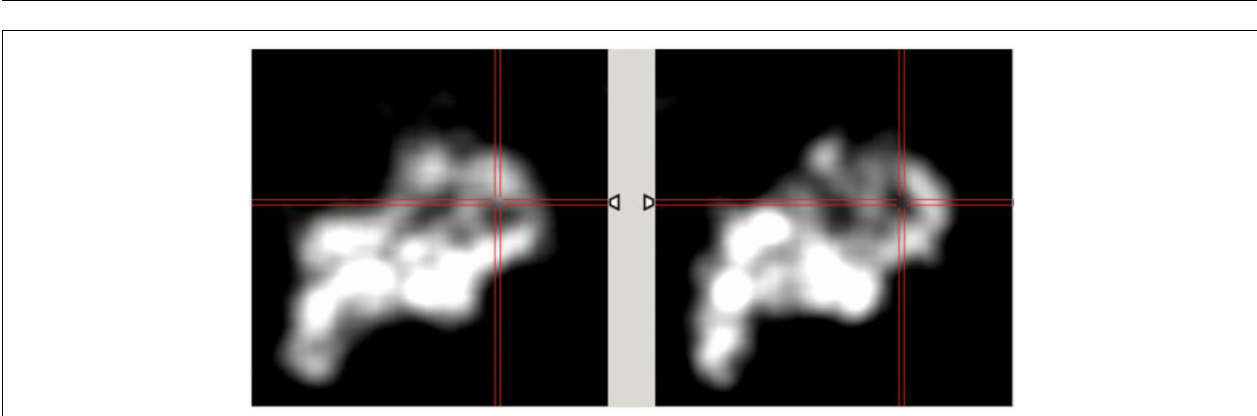
FIGURE 14 | Effect of LV wall non-uniformity (Case 4): Comparison of the difference in LV wall thickness between the ground truth (left) and the reconstructed image.